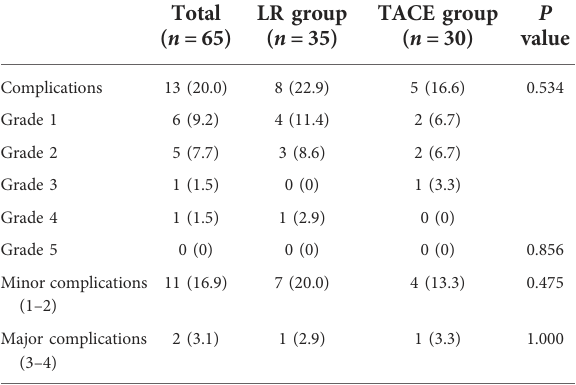
TABLE 3 Postoperative complications in the two patient group n (%).